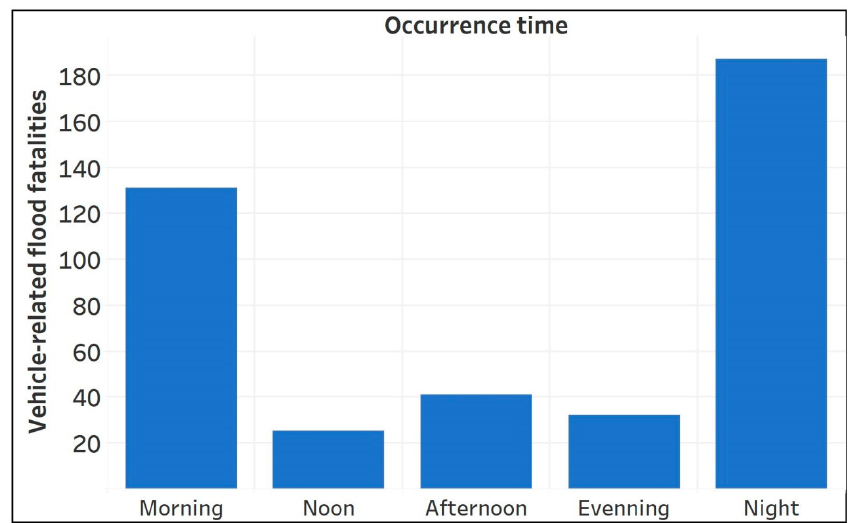
Figure 6. Numbers of vehicle related flood fatalities in Texas, 1959-2019 by occurrence time.